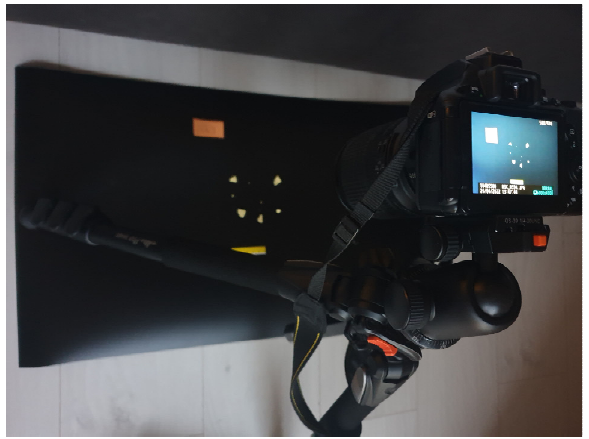
Figure 1. Taking standardized photographs of chewed